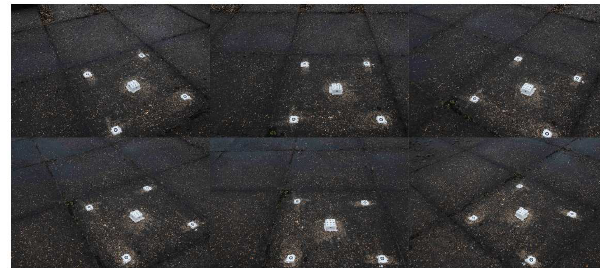
Figure 5: Photogrammetric acquisition of the UAV on-board GPS receiver